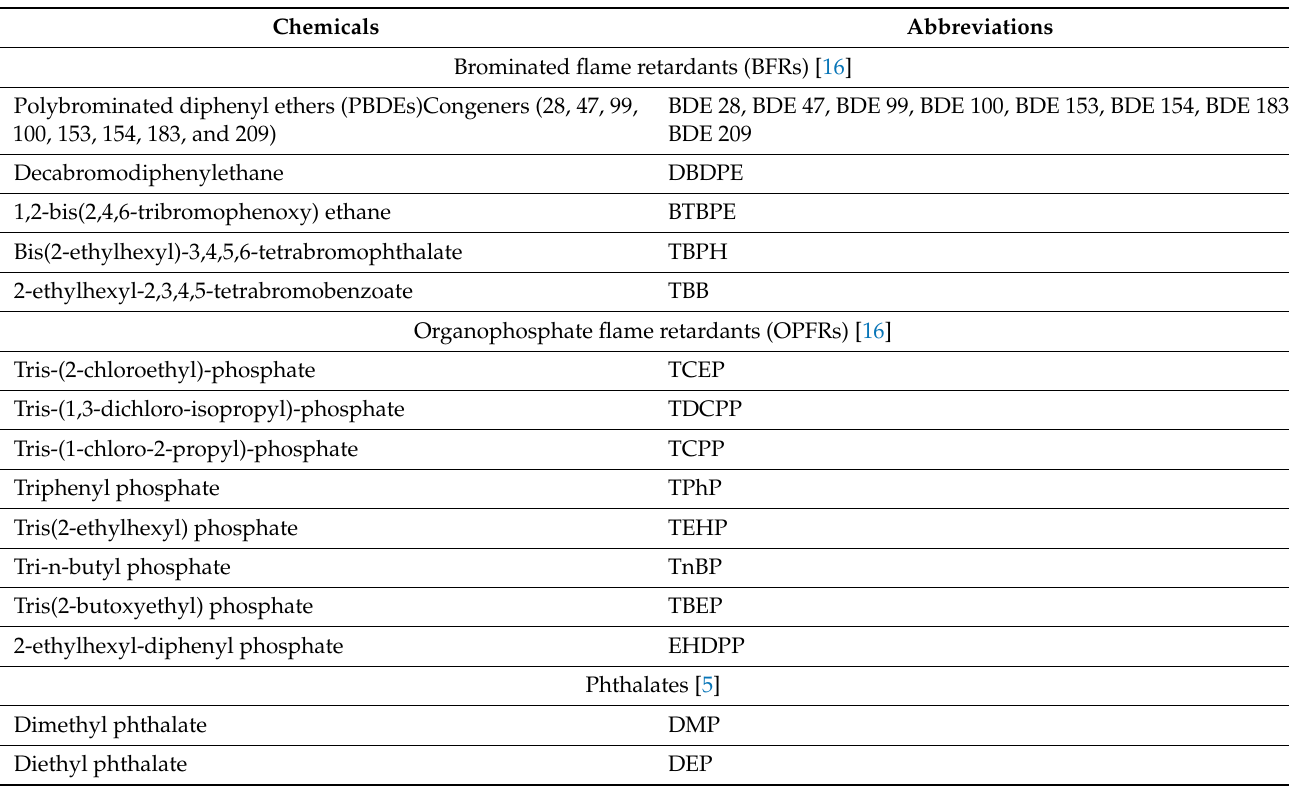
Table 1. Names and abbreviations of chemicals included and references to the published data compiled for this study. Chemicals Abbreviations Brominated flame retardants (BFRs)